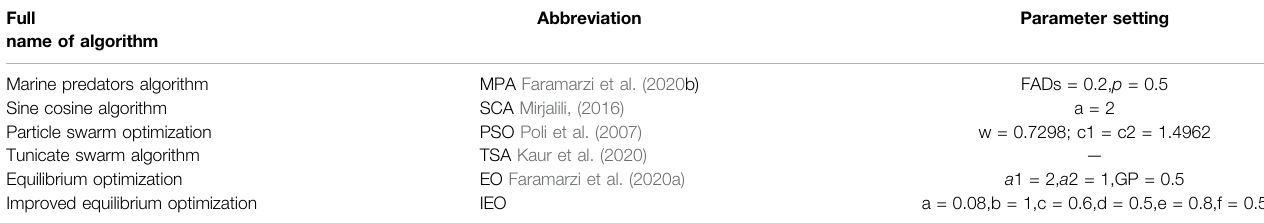
TABLE 1 | Algorithm names and parameter settings.